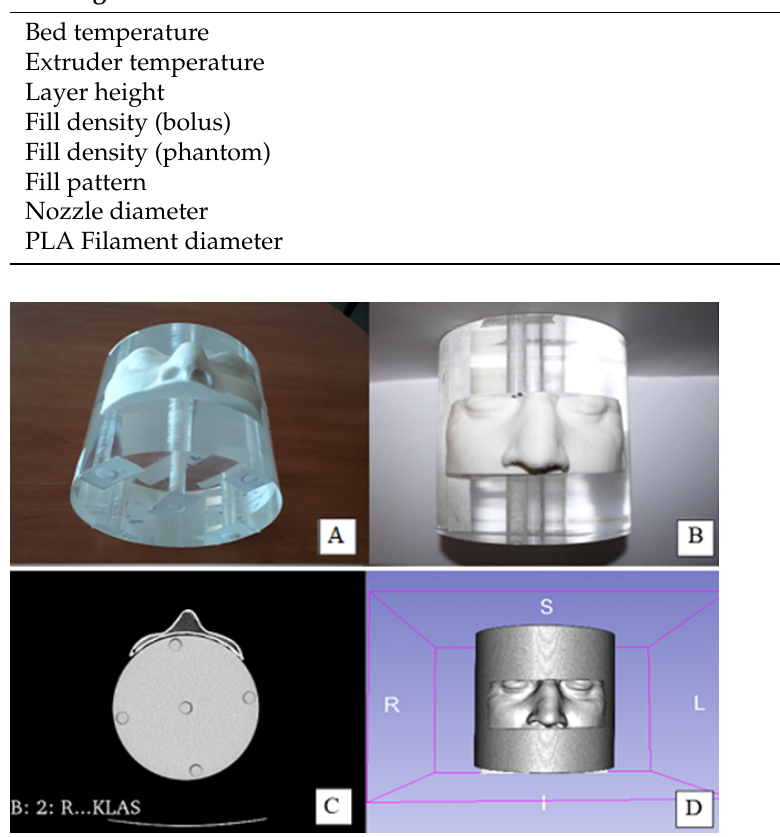
Figure 2. 3D-printed patient-specific phantom: ( A , B ) Phantom–phantom assembly, consisting of the printed phantom attached to the surface of CT head phantom; ( C ) CT image of the phantom–phantom assembly; ( D ) model of phantom–phantom assembly reconstructed from CT